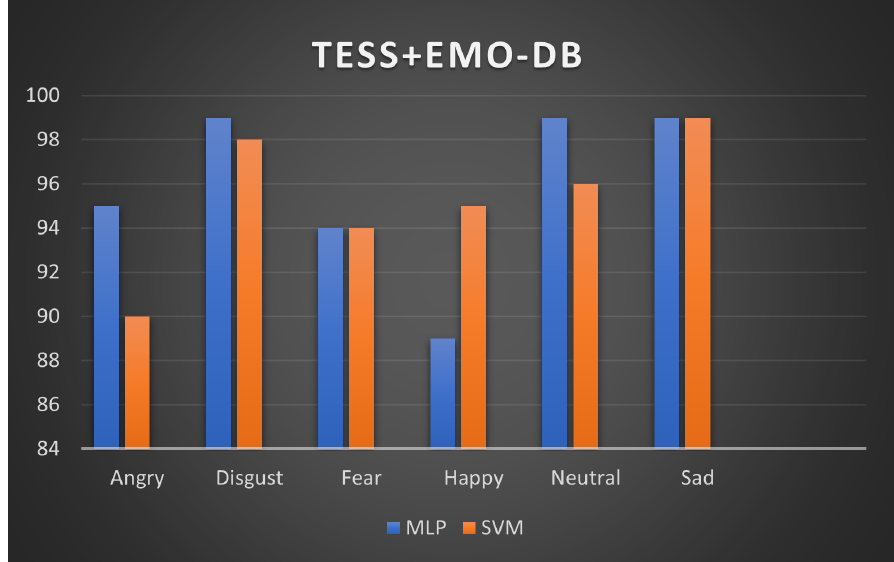
Figure 8. Performance chart on TESS-EMODB with the two